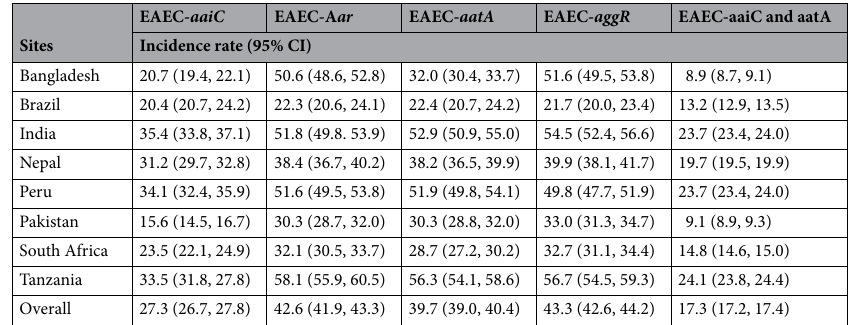
Table 2. The incidence rate of strain carrying genes of EAEC infection across each of the eight study sites (Bangladesh, India, Nepal, Pakistan, South Africa, Tanzania, Brazil, and Peru) from November 2009 to February 2012. 95% CI : 95% confidence interval; Incidence rates were calculated using Poisson regression where outcome variables were a number of infections of EAEC ( strain carrying genes) and offset variables were log of the number of follow